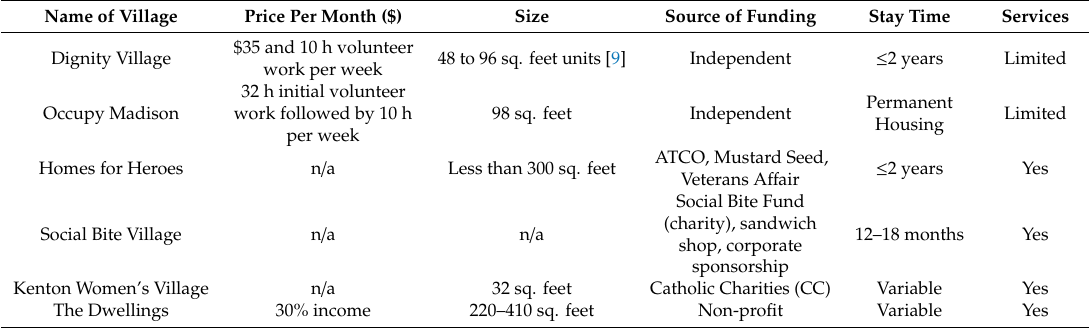
Table 1. Characteristics of some Tiny Villages across the